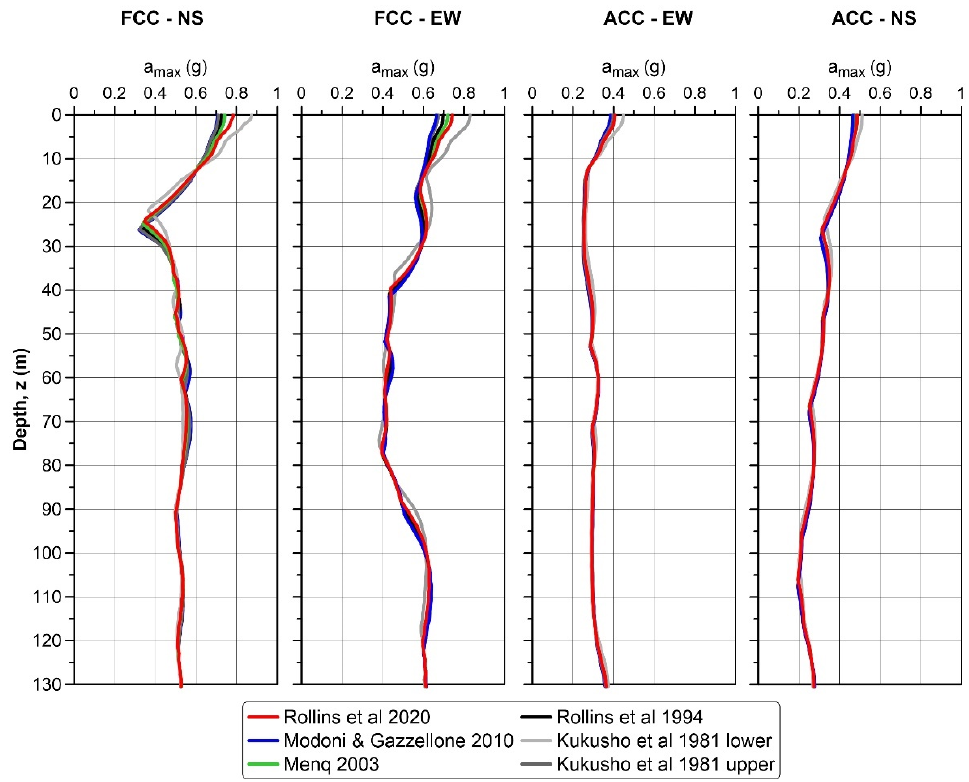
Figure 20. Vertical profiles of maximum acceleration obtained from the equivalent linear analyses. Rollins et al. (2020) [96]; Modoni & Gazellone (2010) [95]; Menq (2003) [94]; Rollins et al. (1994) [93]; Kukusho et al. (1981) [92].